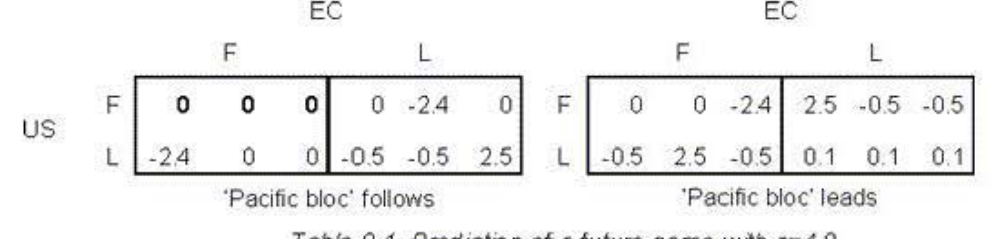
Table 8.1 Predictk>n of a future game w11h c=4.8